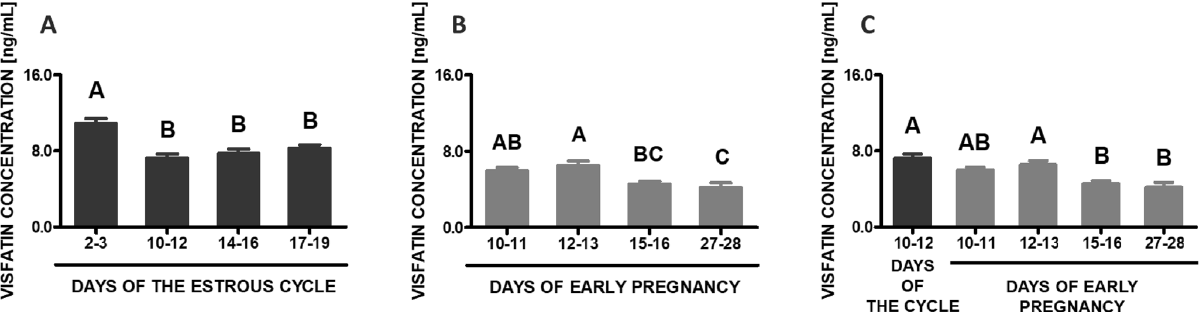
Figure 5. Visfatin concentration in the porcine blood plasma. Concentrations of visfatin in the porcine blood plasma was determined during the estrous cycle on days: 2–3, 10–12, 14–16 and 17–19 ( A ), during early pregnancy on days: 10–11, 12–13, 15–16 and 27–28 ( B ) and compared between early pregnancy and days 10–12 of the estrous cycle ( C ). The hormone content in blood plasma was evaluated using ELISA. Results are presented as means ± SEM (n = 5). Bars with different superscripts are significantly different (one-way ANOVA at p < 0.05 followed by Tuckey post hoc test at p < 0.05).